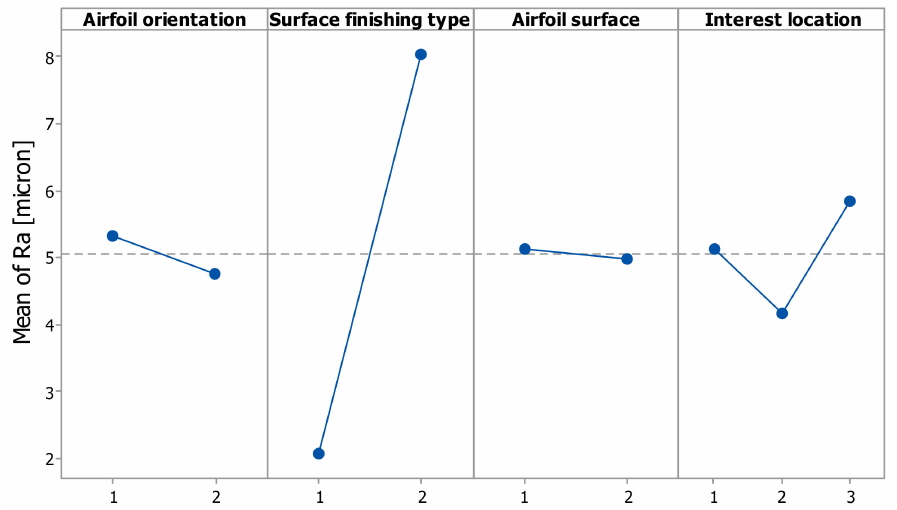
Figure 10. Main effects plot for surface roughness